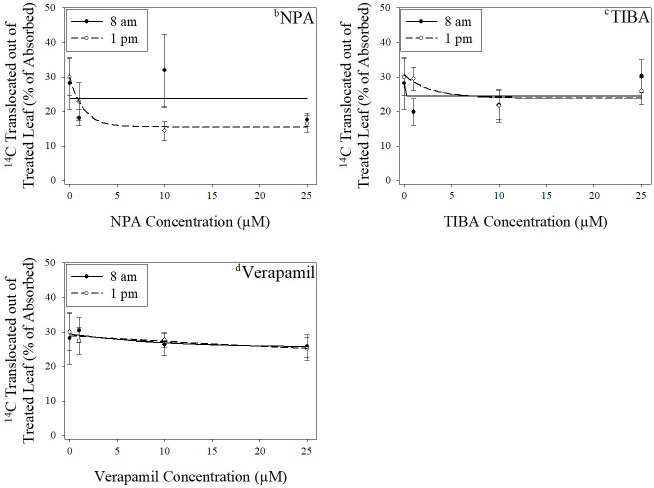
Effect of increasing translocation inhibitor concentrations on translocation of 14C-2,4-D from treated leaves.aVertical bars represent standard error of the mean. bNPA = N-1-naphthylphthalamic acid. cTIBA = 2,3,5-triiodobenzoic acid. dVerapamil = 5-[N-(3,4-dimethoxyphenylethyl)methylamino]-2-(3,4-dimethoxyphenyl)-2-isopropylvaleronitrile hydrochloride. eNPA with 8 am 14C-2,4-D application: Standard error of regression (SER) = 18.09; NPA with 1 pm 14C-2,4-D application: SER = 11.58; TIBA with 8 am 14C-2,4-D application: SER = 14.44; TIBA with 1 pm 14C-2,4-D application: SER = 11.81; Verapamil with 8 am 14C-2,4-D application: SER = 12.28; Verapamil with 1 pm 14C-2,4-D application: SER = 10.42.